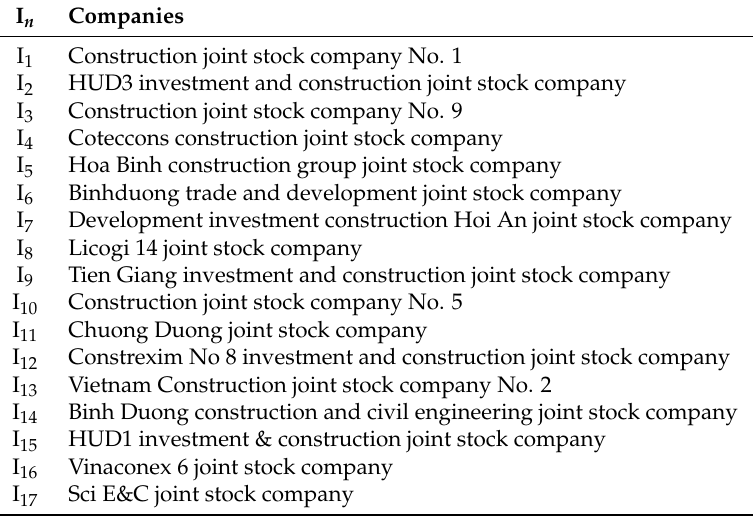
Table 2. List of